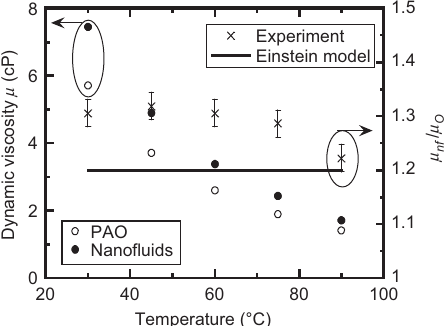
Figure 17 The dynamic viscosity of the pure PAO and the indium- in-PAO PCM fluids (left x-axis) and the relative viscosity of the nano- fluid (right x-axis) vs. temperature. The relative viscosity estimated from the Einstein model (solid line) is also shown for